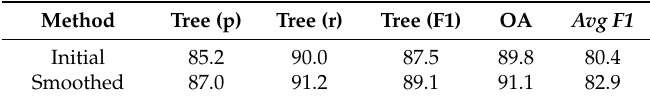
Figure 10. Detailed classification results of a certain selected area. ( a ) the initial classification result; ( b ) the smoothed classification result; ( c ) the ground truth. Table 4. Comparison of the initial and smoothed classification results using DFC 3D dataset. We report the precision (p), recall (r), and F1 score for tree category in the first 3 columns as well as the OA and Avg F1 in the last two columns (All values are in %).